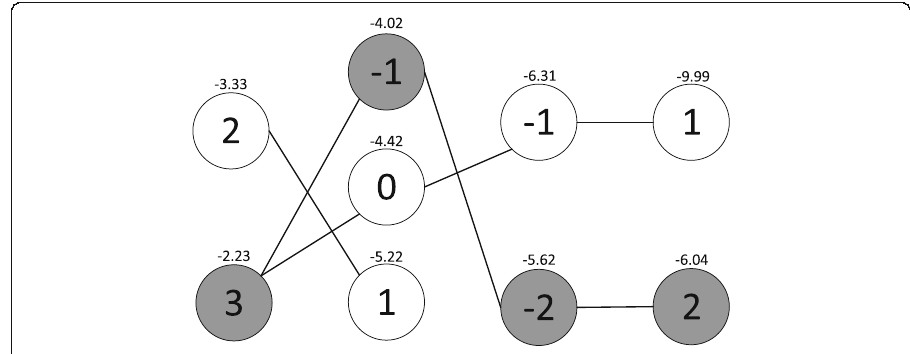
Fig. 4 The trellis for Viterbi algorithm based on the first-order cover probability